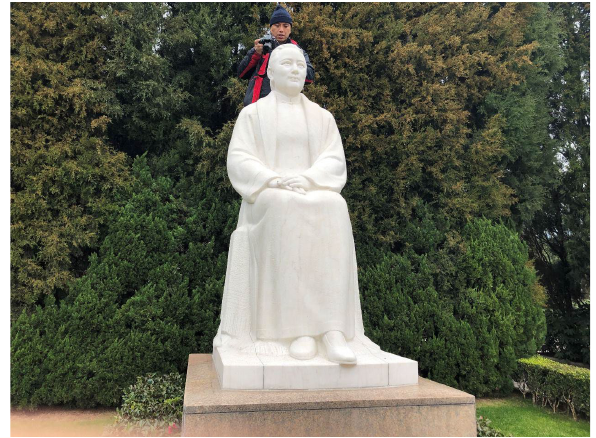
Figure 3 . Documentation undergoing, 2019. (Source: Tongji- ACL)